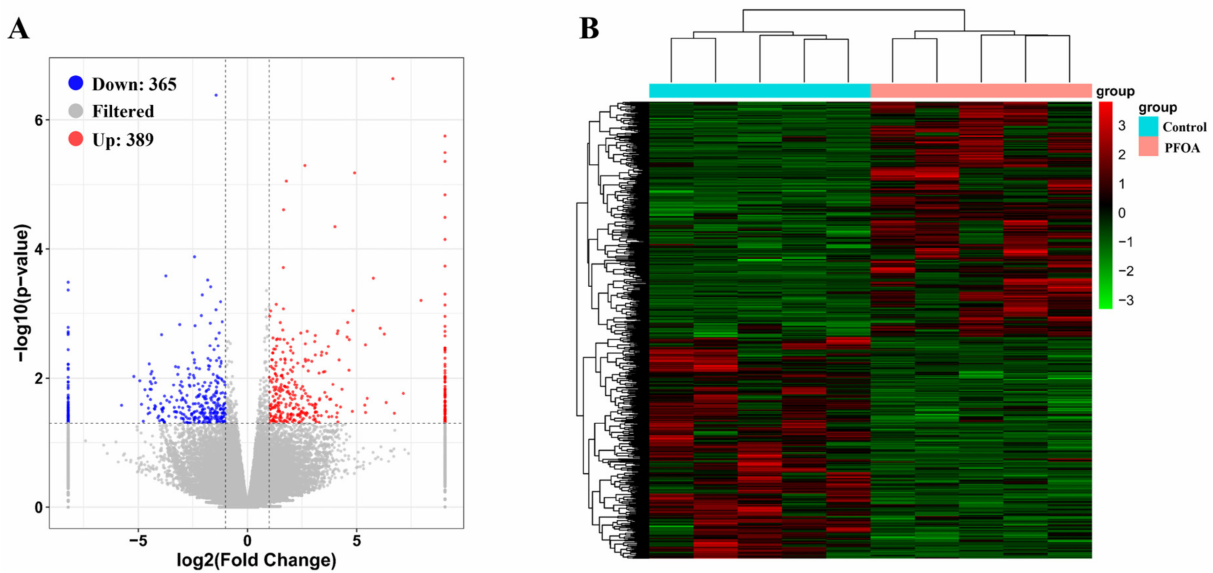
Figure 1. DEGs in the PFOA exposure group compared with the control group. ( A ) Volcano map. ( B ) Clustering thermogram. The clustering bars gather samples of similar expression patterns. The intensity of the colors shows the magnitude changes of